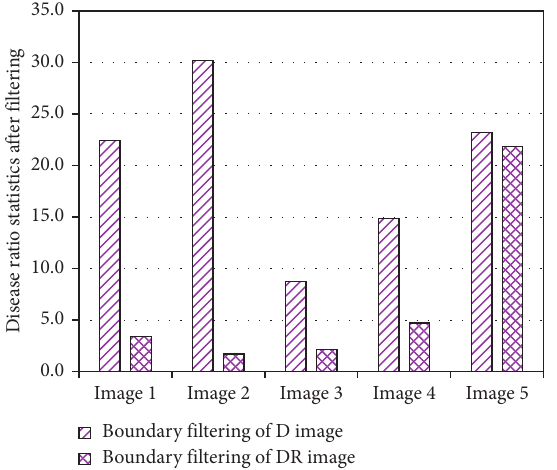
Figure 9: Comparative analysis of the statistical boundary filtering ratio of the image after dark channel dehazing and processing by the DR